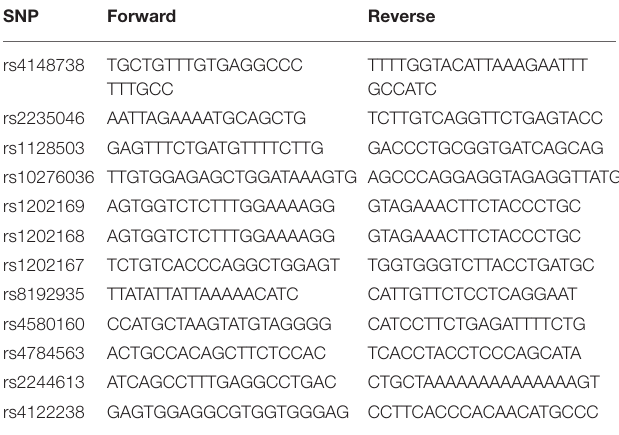
TABLE 3 | The polymerase chain reaction primers of ABCB1 and CES1.